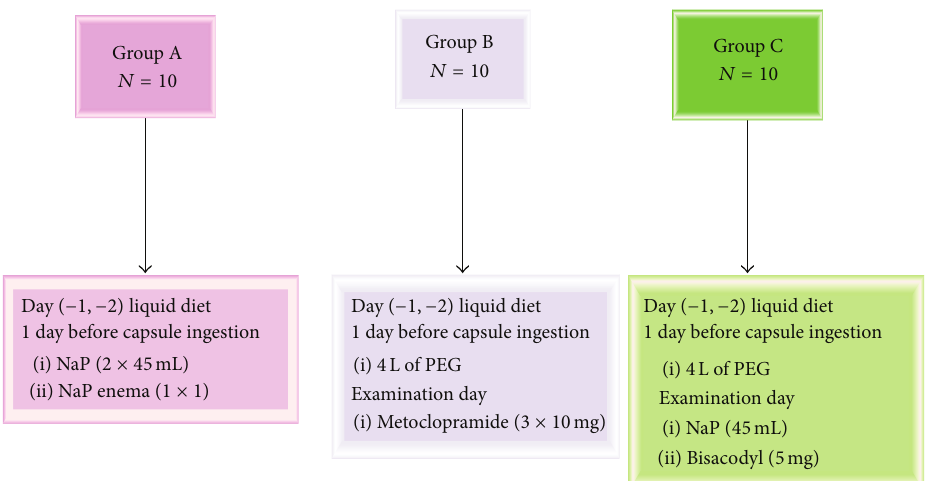
Figure 1: Cleaning regimens of this study (PEG: polyethylene glycol; NaP: sodium